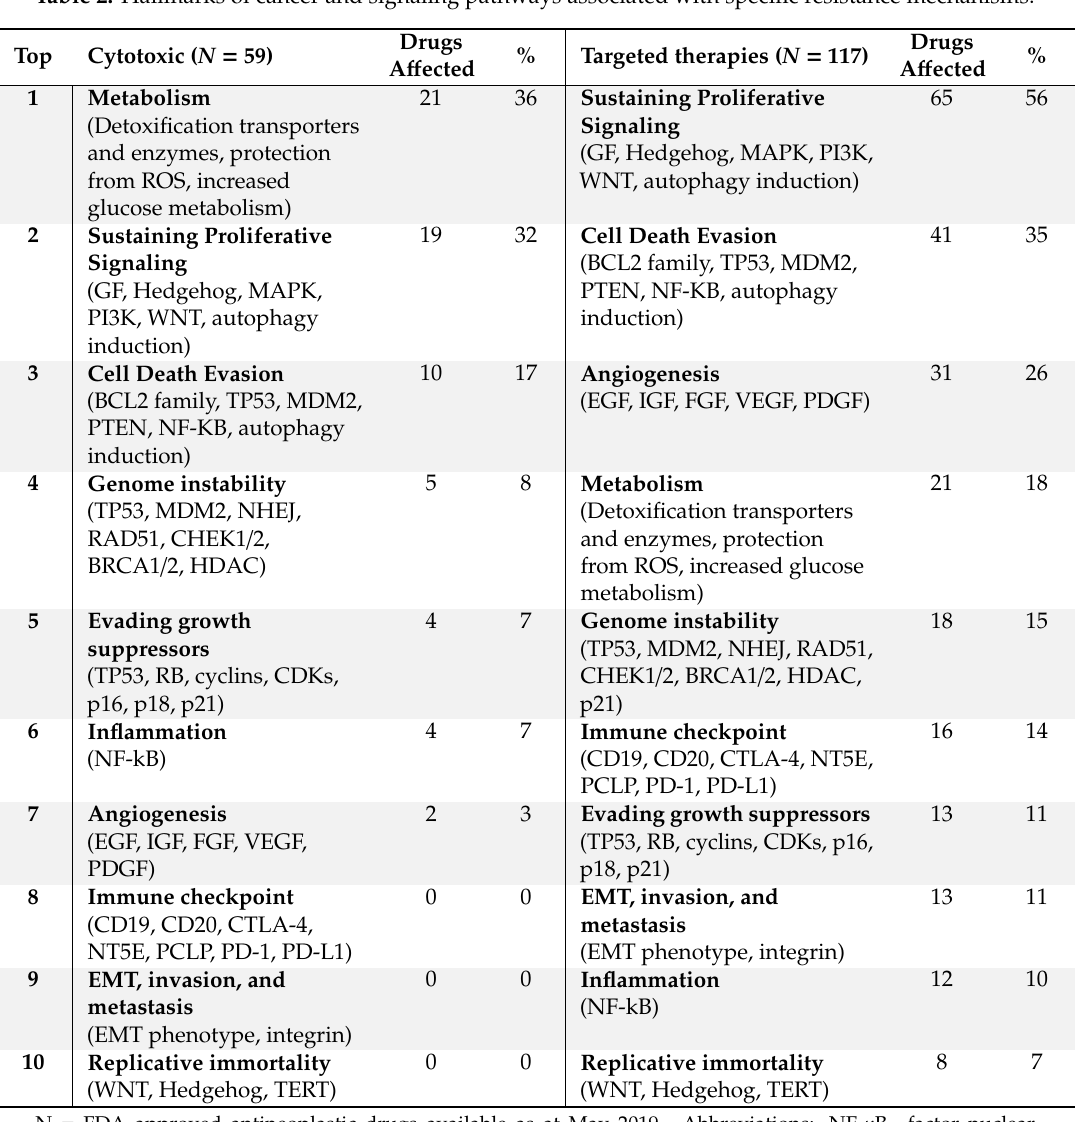
Table 2. Hallmarks of cancer and signaling pathways associated with specific resistance